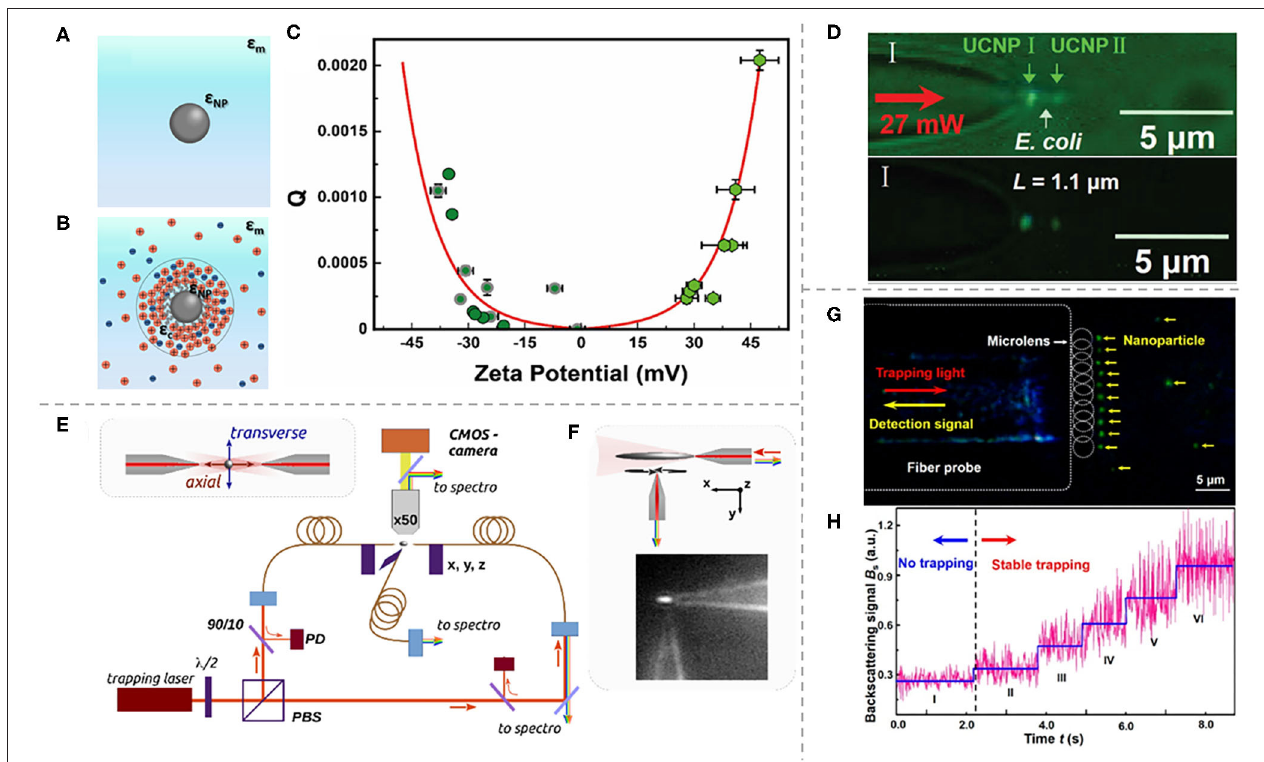
FIGURE 1 | Optical trapping of a NP:Ln in a solvent by different systems based on the reduction of the optical trap volume. (A) A ligand-free lanthanide-doped dielectric NP (permittivity ε NP ) in a medium (permittivity ε m ). (B) A dielectric NP:Ln coated with ligands (coating permittivity ε c ). The electric double layer is indicated by the circles. (C) Optical trapping strength, represented by the Q-factor, as a function of the zeta potential for different types of NP:Ln. Adapted with permission from Rodríguez-Sevilla et al. (2018). Copyright 2018 American Chemical Society. (D) Bright-field (top) and dark-field (bottom) images of two NPs:Ln (I and II) and an E. coli bacterium trapped in a row by optical fiber tweezers. Adapted with permission from Xin et al. (2017). Copyright 2017 John Wiley and Sons. (E) Schematic of a dual optical fiber tweezer system. (F) Schematic and microscopy image of a single fiber tip trap including the auxiliary fiber tip used for particle emission recording of a single NP:Ln. OSA Open Access License for OSA-Formatted Journal Article PDFs ( Leménager et al., 2018). (G) Tip of an optical fiber with an array of coupled spherical microlenses that are able to trap nanoparticles. The fiber probe also records the detection signal. The sequential growth, in backscattering signal, as different nanoparticles are trapped by the microlenses is shown in (H) . Adapted with permission from Li Y. et al. (2016). Copyright 2016 American Chemical